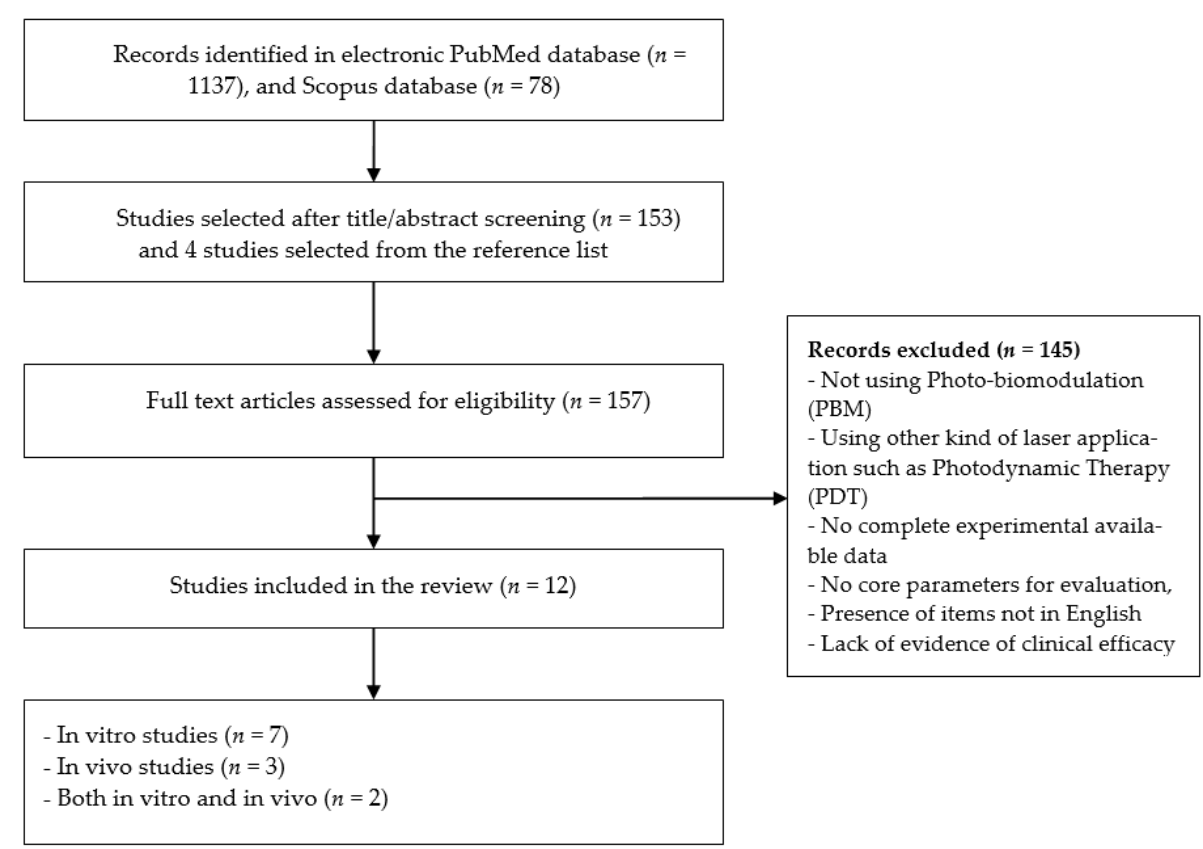
Figure 1. Flow diagram of the evaluation process of publications.